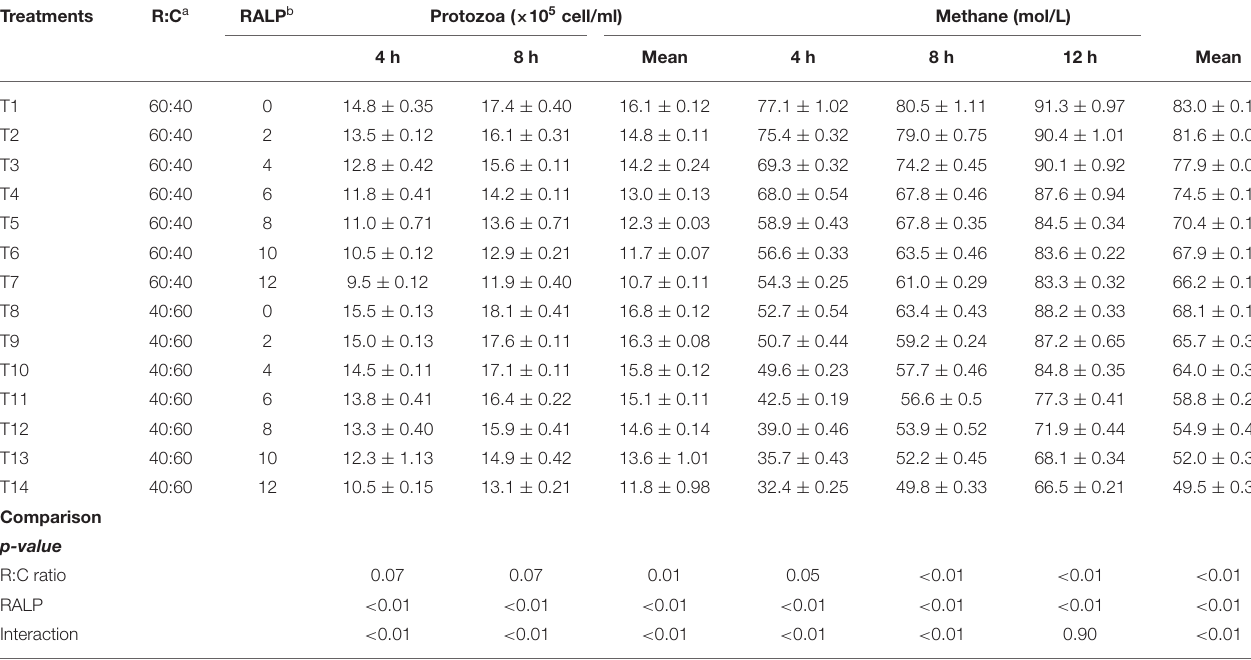
TABLE 4 | Effect of RALP supplementation on protozoal population and methane production.